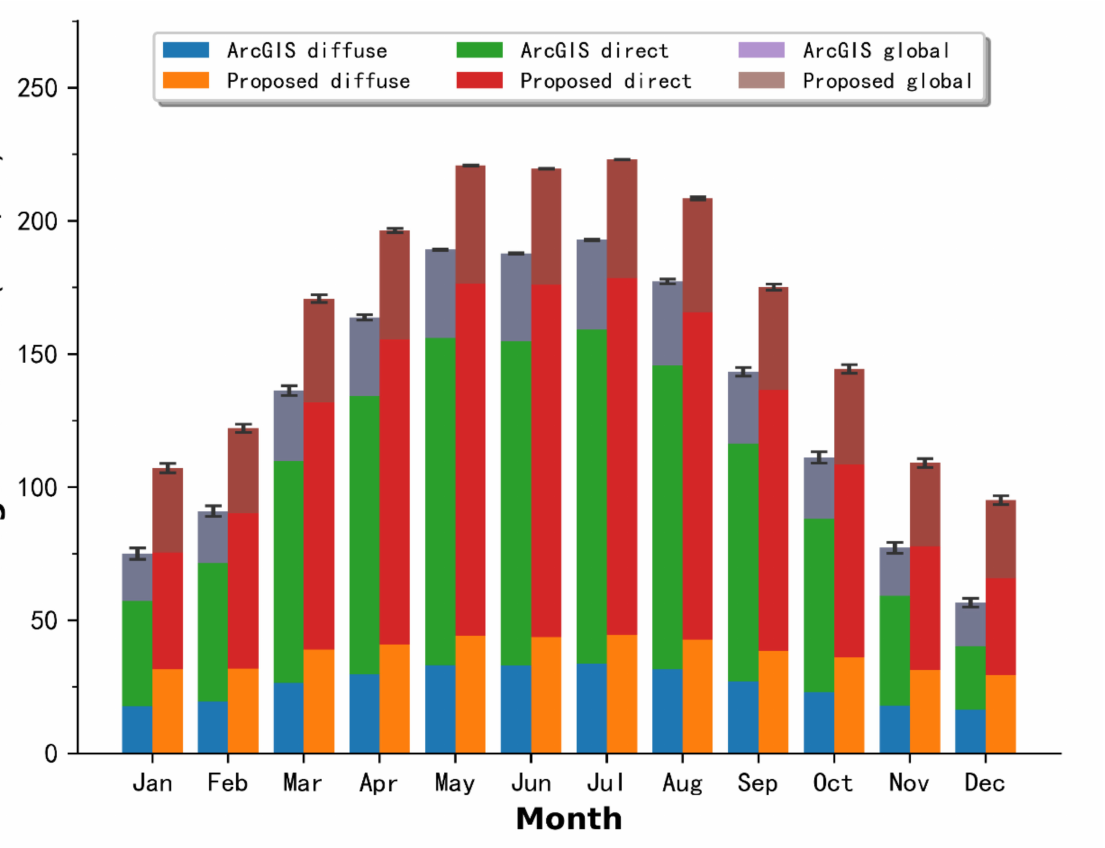
Figure 13. Comparison of monthly solar irradiance calculated by the proposed method and ArcGIS methods in area